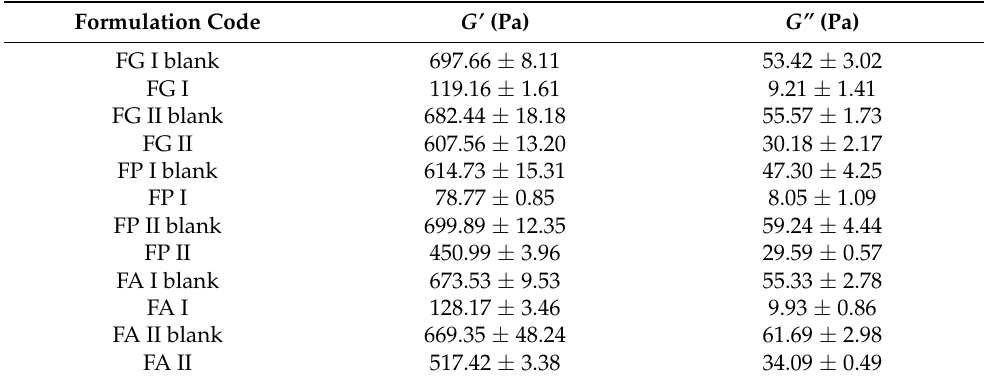
Table 4. The results of the amplitude sweep test for the studied liposomal